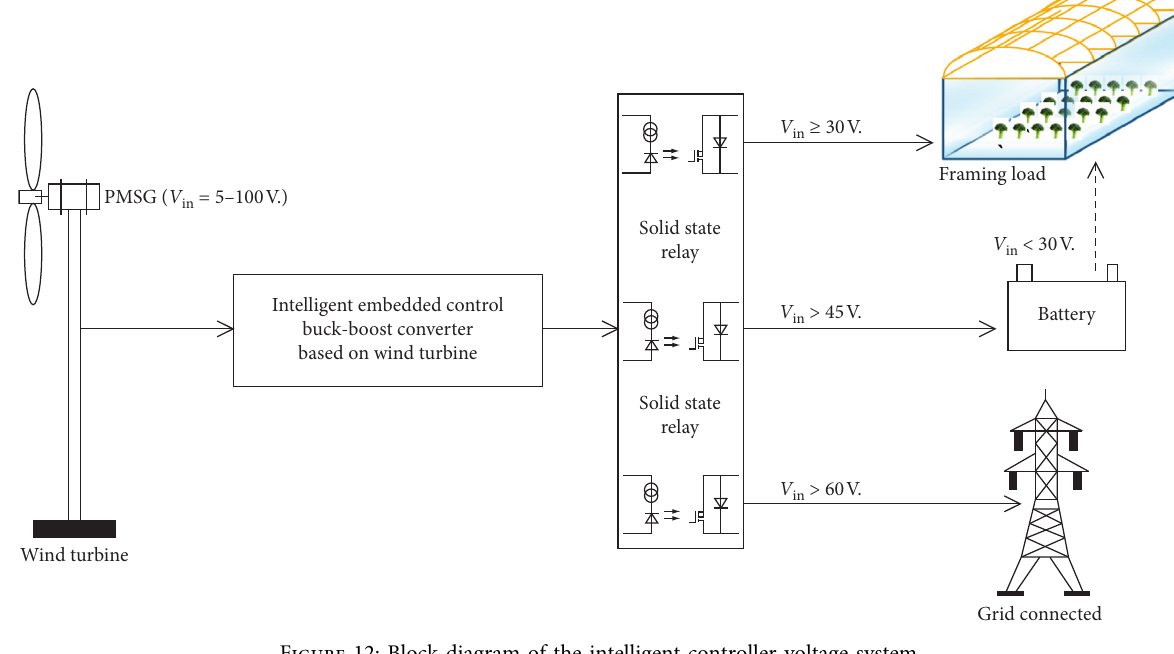
Figure 12: Block diagram of the intelligent controller voltage system.